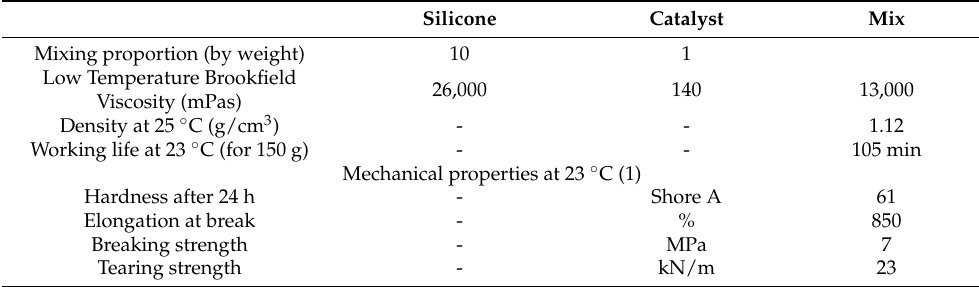
Table 1. Physical properties of the mold material (silicone type Xiameter RTV-4250-S). Silicone Catalyst Mix Mixing proportion (by